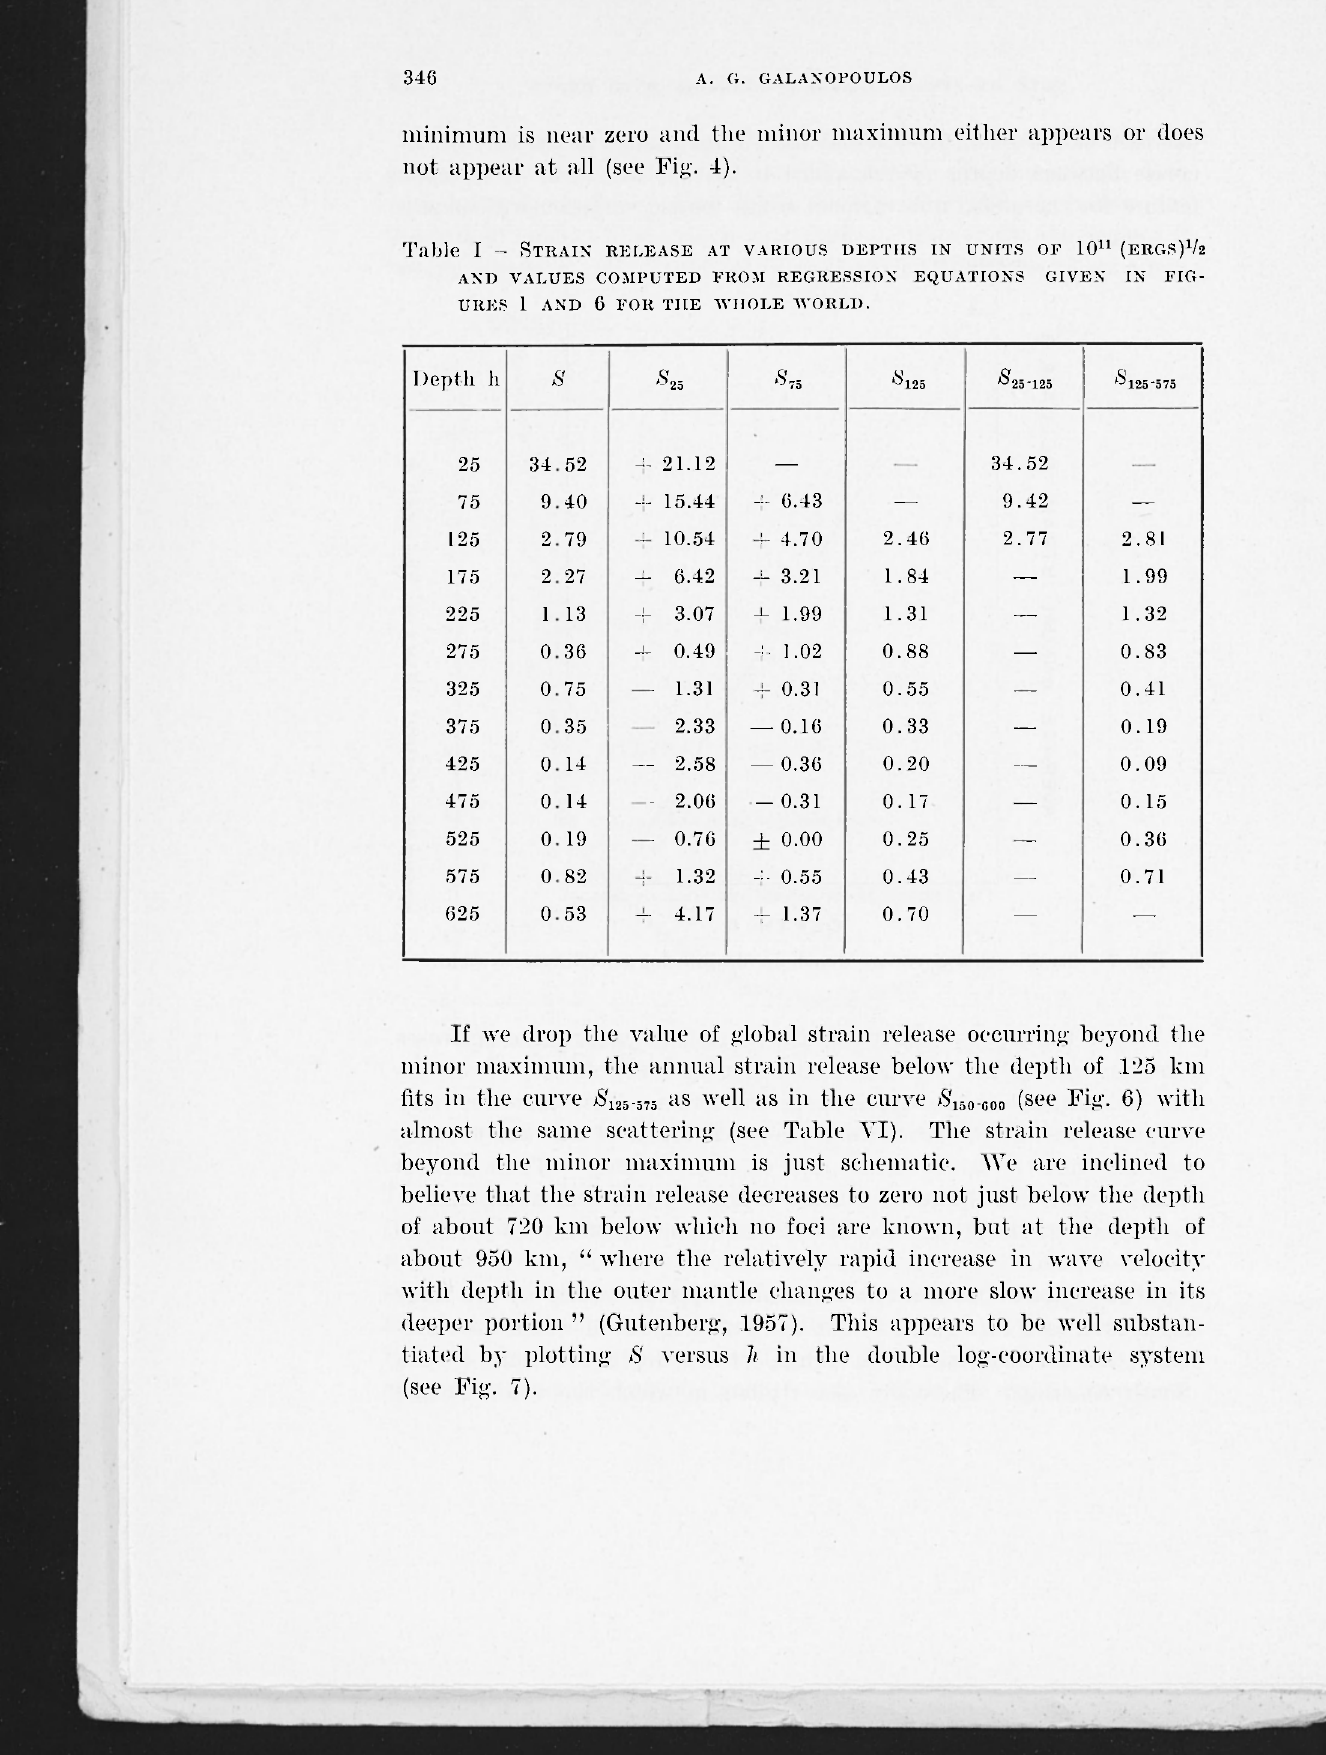
Table I - STRAIN RELEASE AT VARIOUS DEPTHS IN UNITS or 10 11 (ERGS) 1 ^ AND VALUES COMPUTED FROM REGRESSION EQUATIONS URES 1 AND 6 FOR THE WHOLE